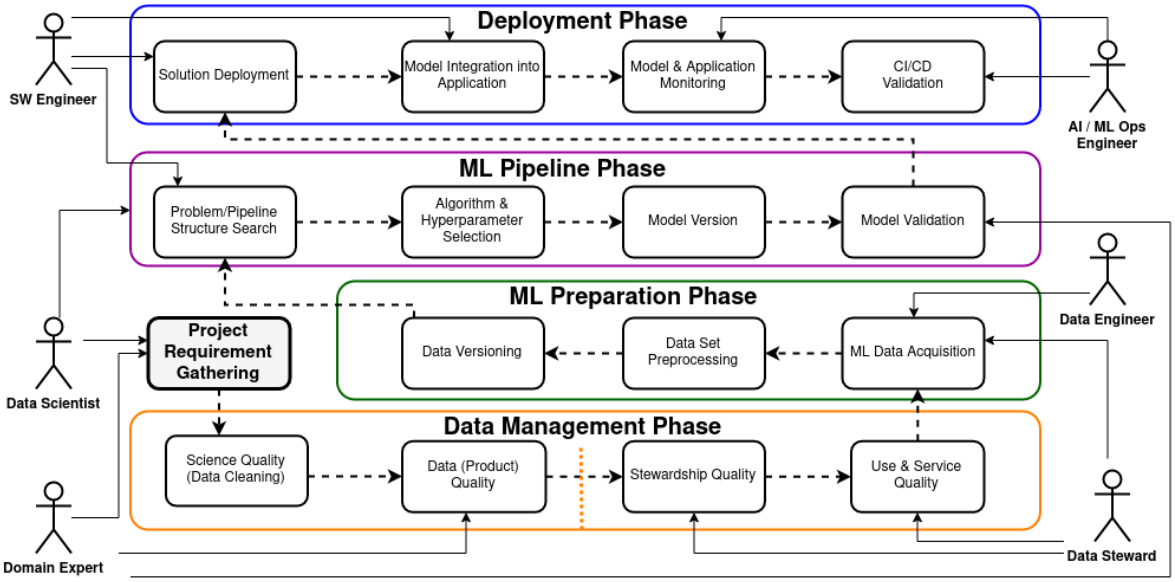
Figure 2. Common actors in MLOps and their responsibilities throughout the